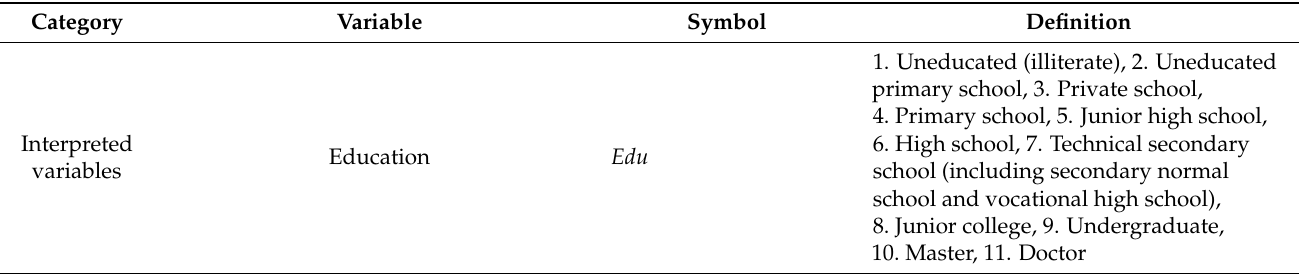
Table 3. Interpreted, explanatory and control